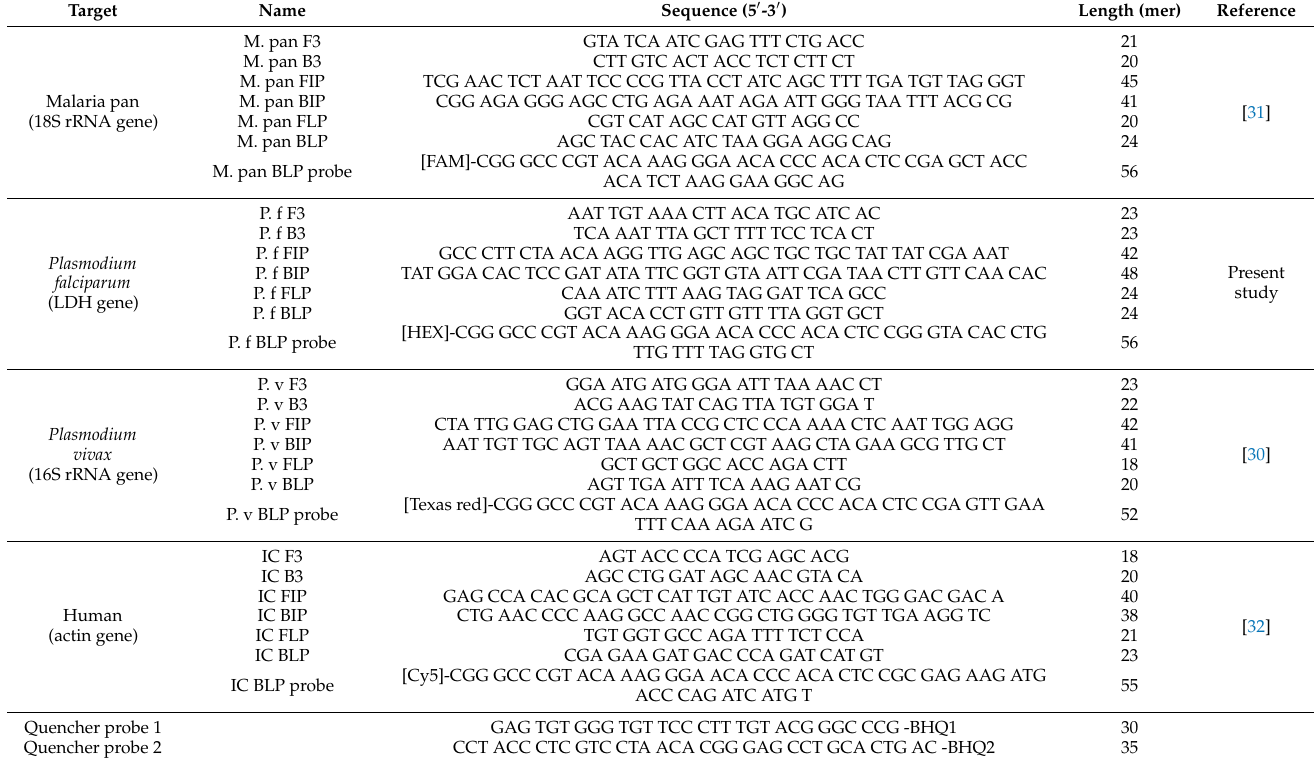
Table 1. Primer sets used in the multiplex malaria Pan/Pf/Pv/IC